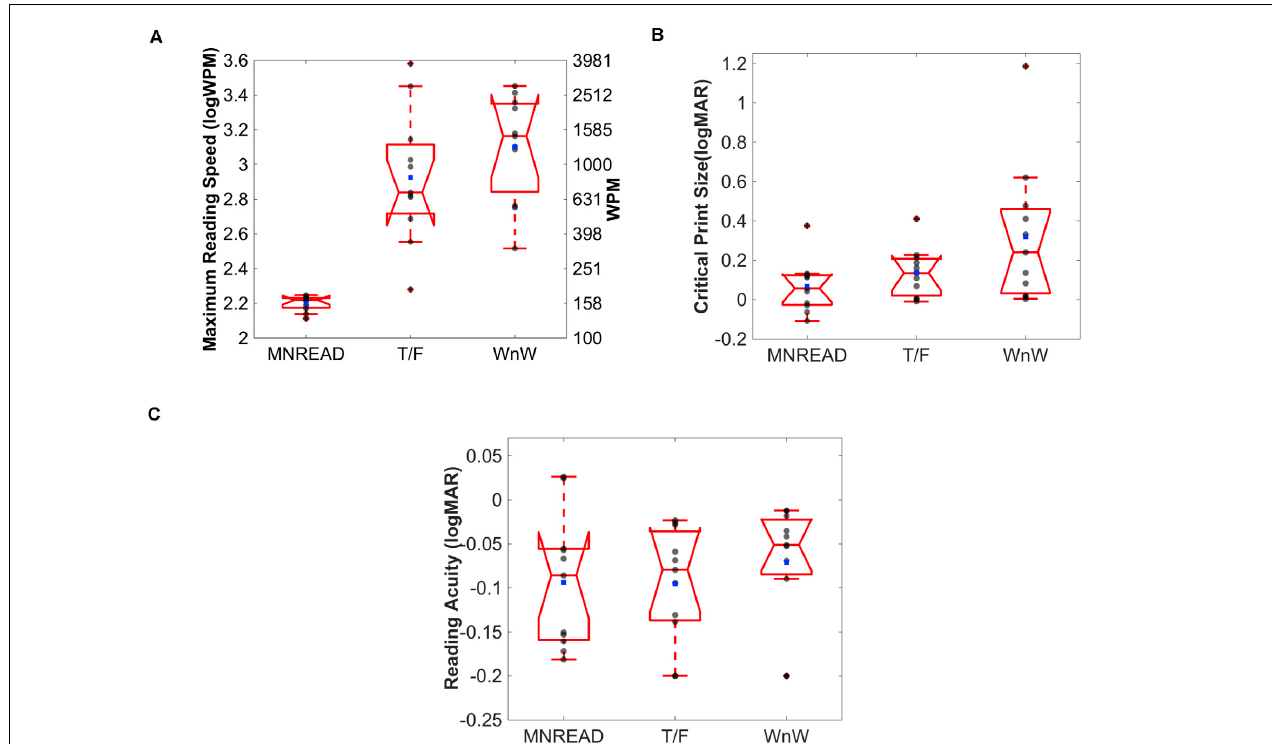
FIGURE 5 | Boxplots for median maximum reading speed (A) , critical print size (B) and reading acuity (C) for each reading task. Solid red line represents the median, and the notch represents the 95% confidence interval of the median. The upper and lower whiskers represent values outside 50% of the data. Individual observers illustrated as gray scatter points, and blue box as the